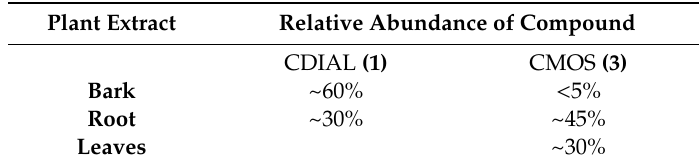
Table 1. Relative abundances of compounds 1 and 3 in the extracts of Cinnamosma species. Percentages were estimated using the integration of the 1 H